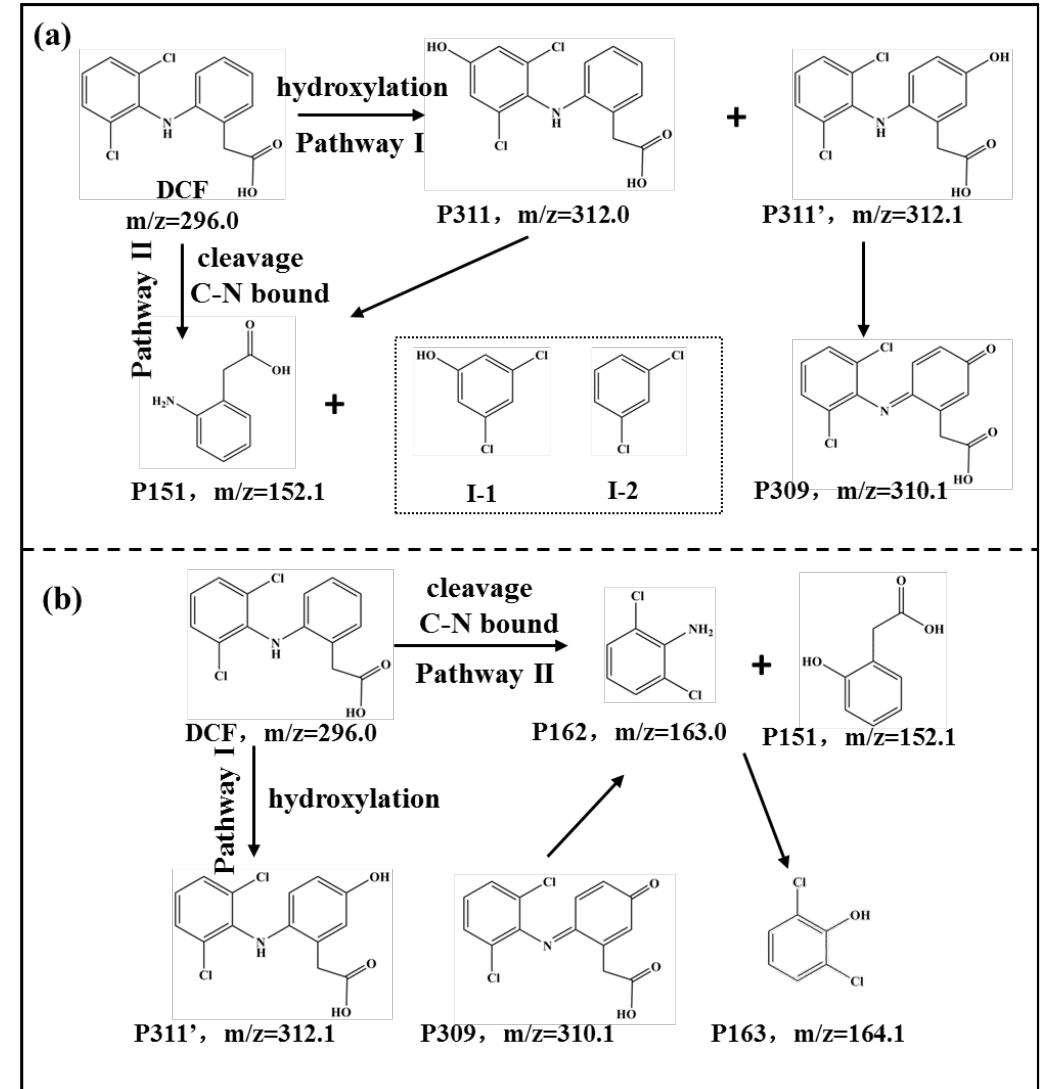
Figure 5. Proposed pathways of DCF degradation by ( a ) MnOMs and ( b ) Bio-MnOx.